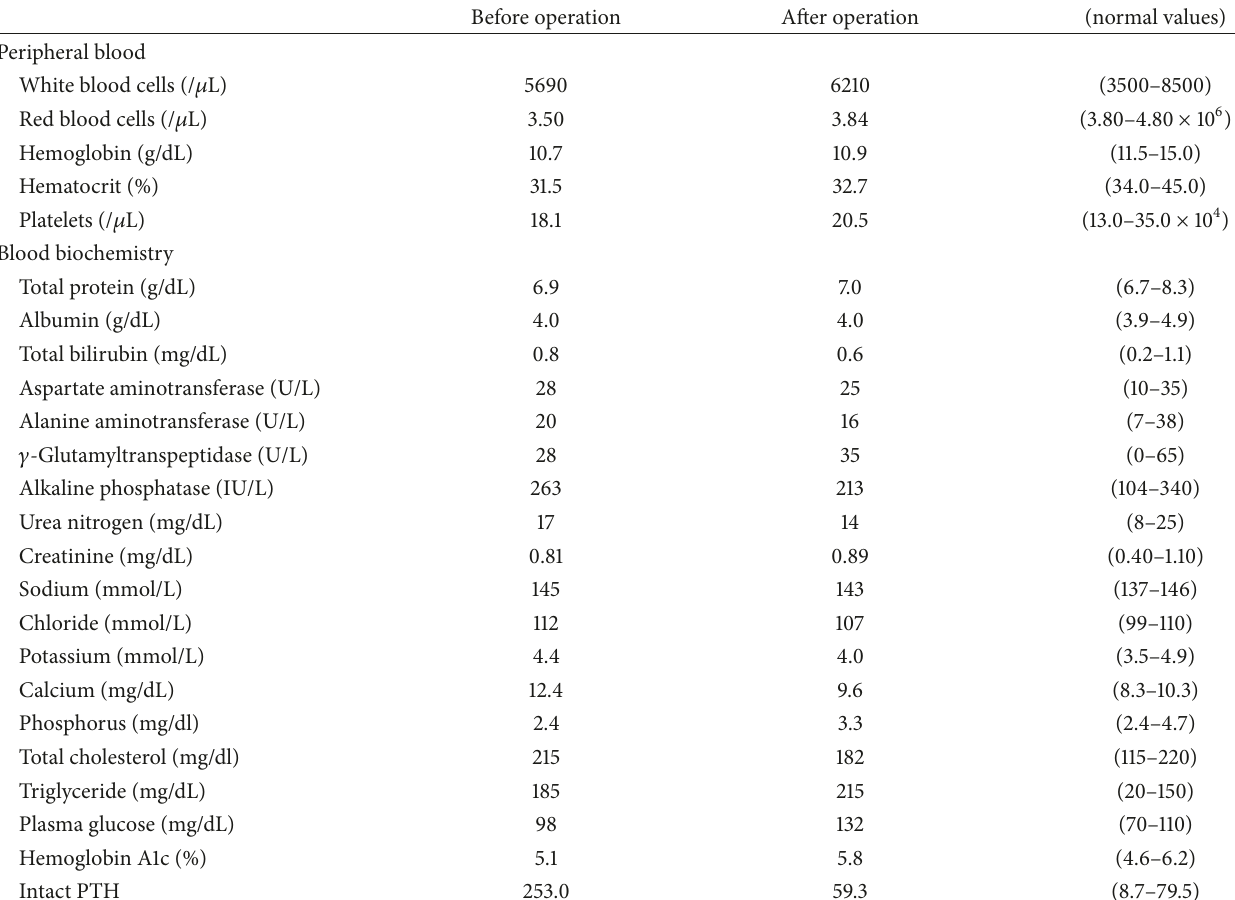
Table 1: General laboratory